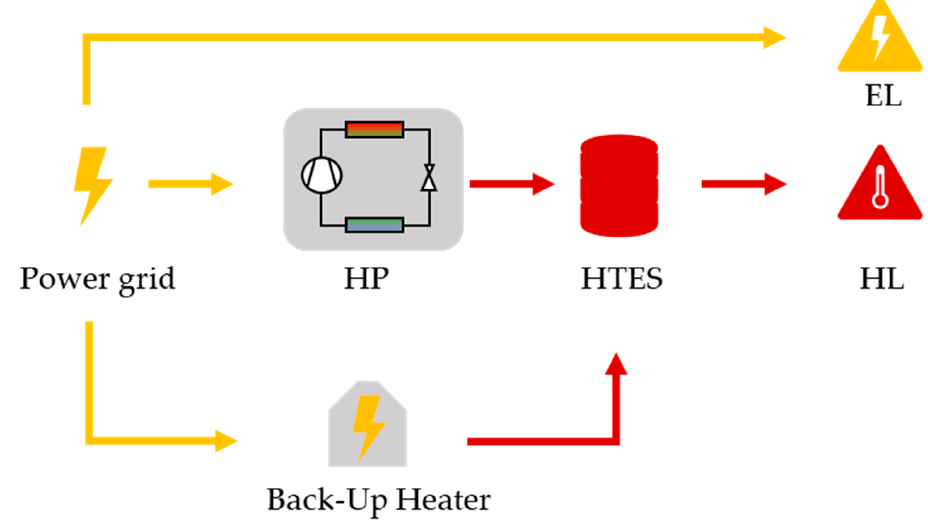
Figure 2. Schematic representation of the HP scenario set-up.